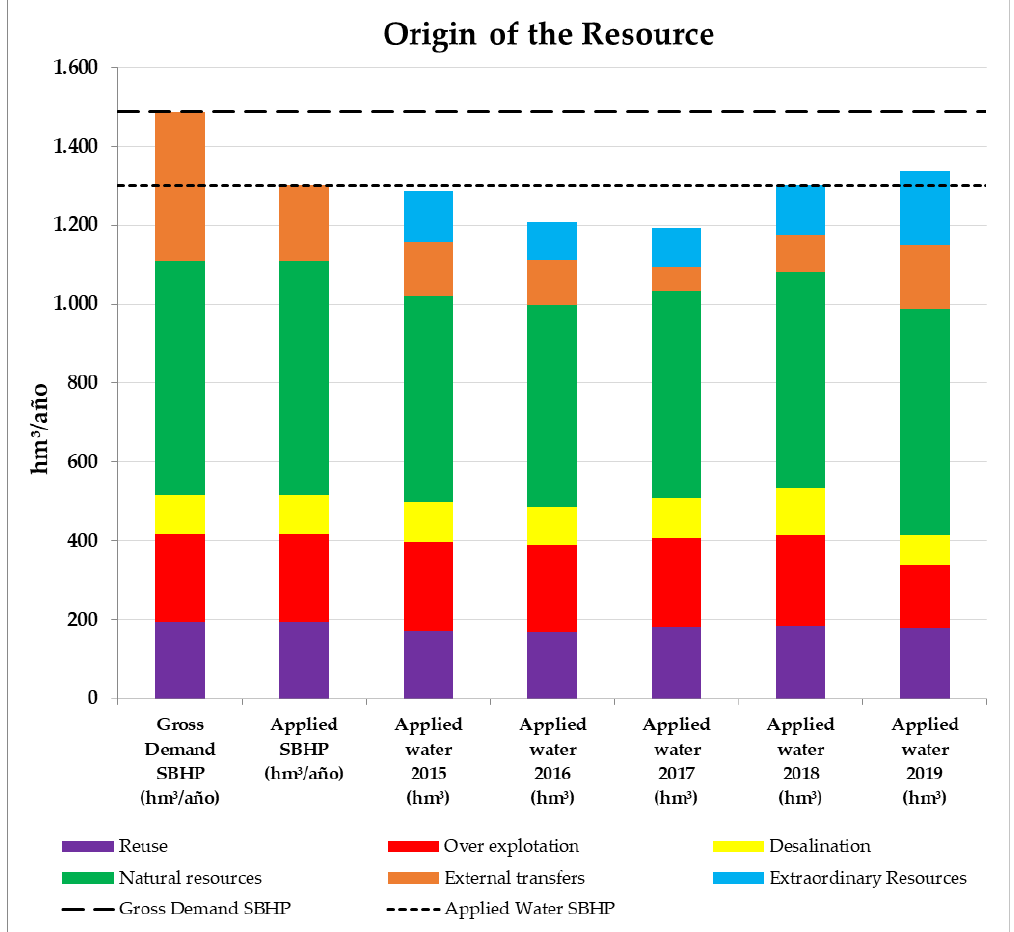
Figure 6. Origin of the applied water resources 2015–2019 Source: HPO. Own elaboration. After analysing the irrigated area and the applied water, the production value and net margin associated with each UAD are analysed, taking as a base the economic characterisation of the use of irrigation carried out in the SBHP 2015/21, through the use of functions relating to each UAD and depending on the availability of water (applied water), the production value and net margin. For the years of drought the procedure previously indicated has been followed, substituting the values of applied water of each year in the individual curves of each UAD. Tables 9 and 10 show the values obtained: